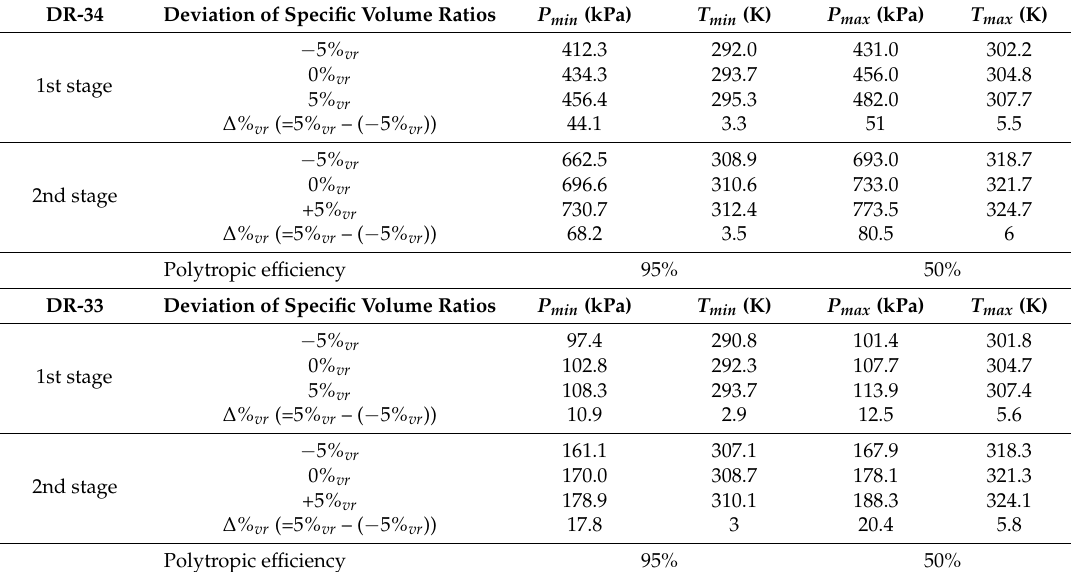
Table 4. Minimum and maximum value of pressure and temperature at outlet by deviation of specific volume ratios for polytropic efficiencies of 50% and